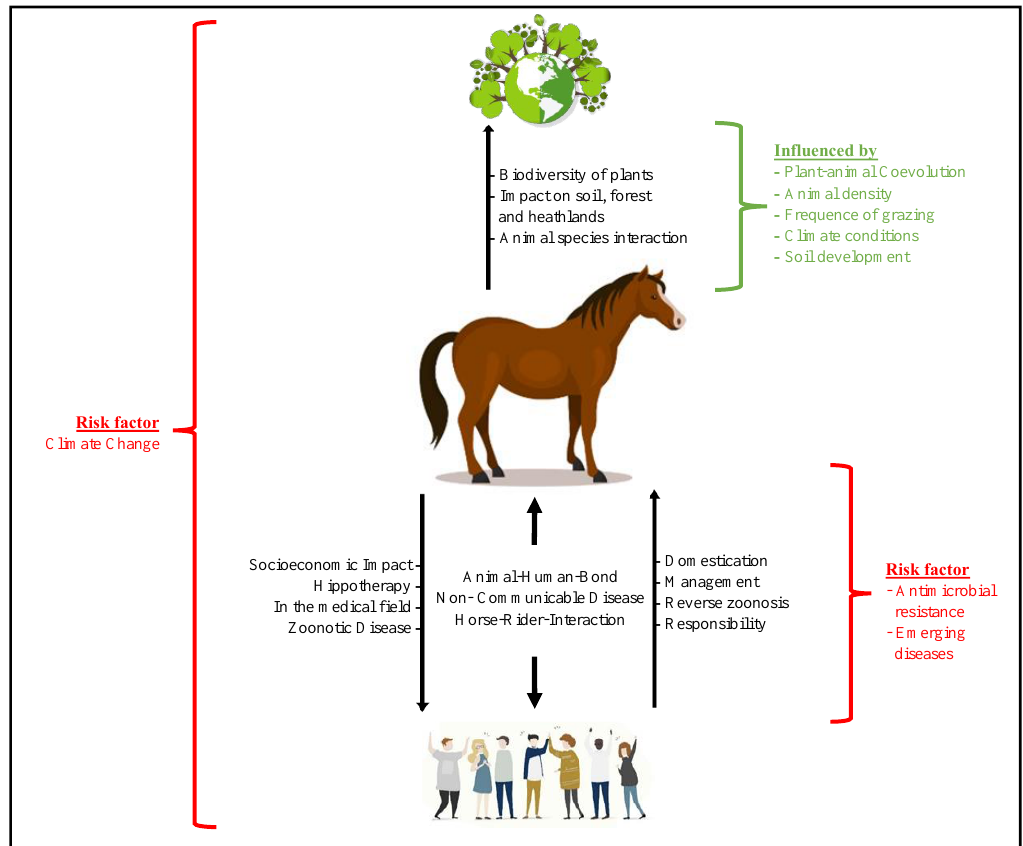
Figure 1. Horse, human and environment interaction pathways. (Symbols: freepic.com).